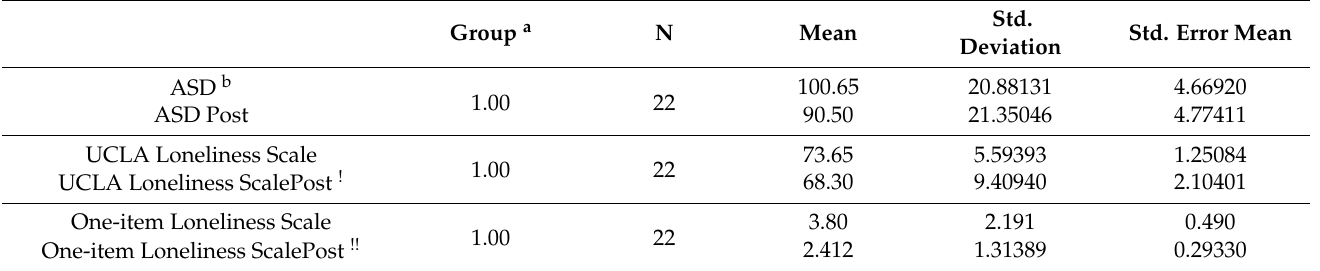
Table 2. Pre-Post Senior Assessment